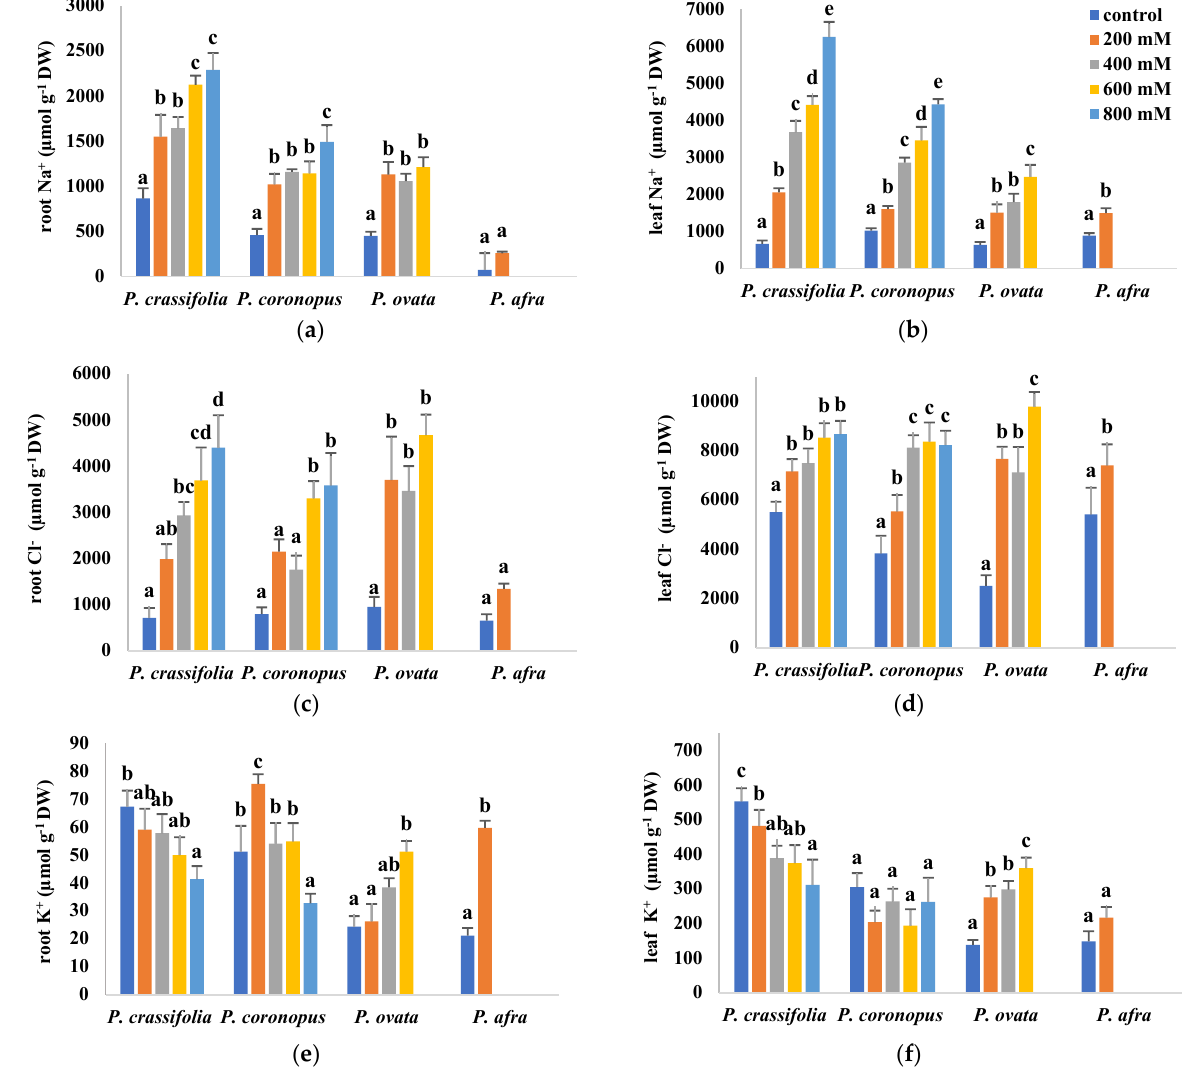
Figure 5. Root ( a , c , e ) and leaf ( b , d , f ) contents of sodium (Na + ), ( a , b ), chloride (Cl - ) ( c , d ) and potassium (K + ) ( e , f ) in plants of the four selected Plantago species, after four weeks of treatment with the indicated NaCl concentrations. The values shown are means ± SE ( n = 5). For each species, different letters over the bars indicate significant differences between treatments, according to the Tukey test ( p < 0.5).